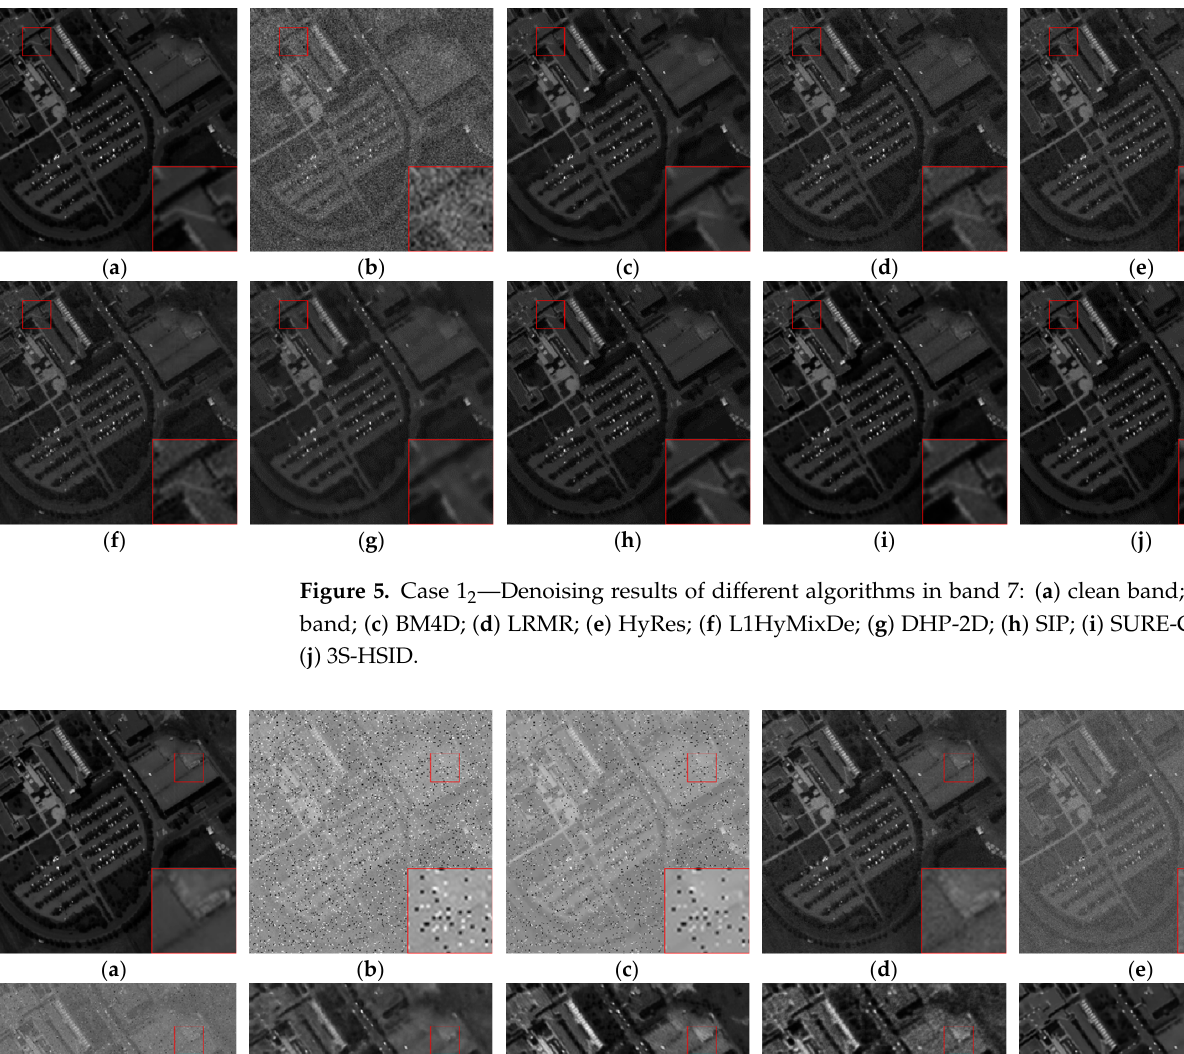
( j ) Figure 7. Case 4—Denoising results of different algorithms in band 19: ( a ) clean band; ( b ) noisy band; ( c ) BM4D; ( d ) LRMR; ( e ) HyRes; ( f ) L1HyMixDe; ( g ) DHP-2D; ( h ) SIP; ( i ) SURE-CNN; and ( j ) 3S-HSID. The denoising performance of the various algorithms cannot be fully evaluated from a single-band visualization analysis. Thus, we also analyzed the denoising results from different aspects, as shown in Figures 8–11. In Figure 8, we chose the simulated data case1 1 to extract the spectral curve of one pixel in the image (row = 220, column = 113) and analyzed the spectral recovery perfor- mance of each algorithm; the results are shown in Figure 8. From the figure, it can be seen that all of the denoising algorithms adequately restored the spectral characteristics of